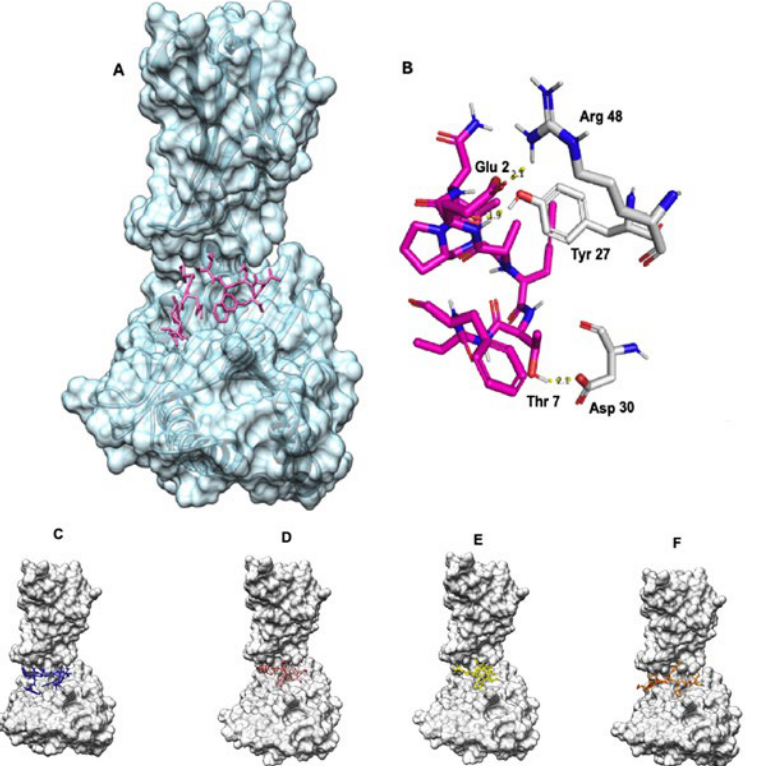
Fig. 3. (A) AENPVFTVF-HLA-B*4402 complex where the epitope is coloured in pink (B) Hydrogen bonding where the epitope is coloured in pink while the MHC molecule is coloured in white. Blue represents nitrogen and red oxygen. (C) FLVRTEFKY-HLA-B*4402 complex where the epitope is coloured in blue. (D) PEICWEGVY-HLA-B*4402 complex where the epitope is coloured in brown. (E) VGFLVRTEF-HLA-B*4402 complex where the epitope is coloured yellow. (F)AMDEGYFAY-HLA-B*4402 complex where the epitope is coloured in orange.